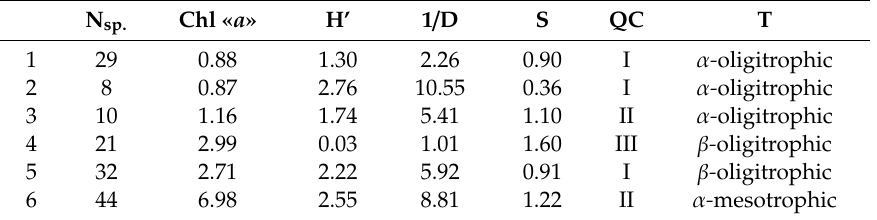
Table 2. Some phytoplankton parameters and water trophic state. N sp .—subgenera taxa